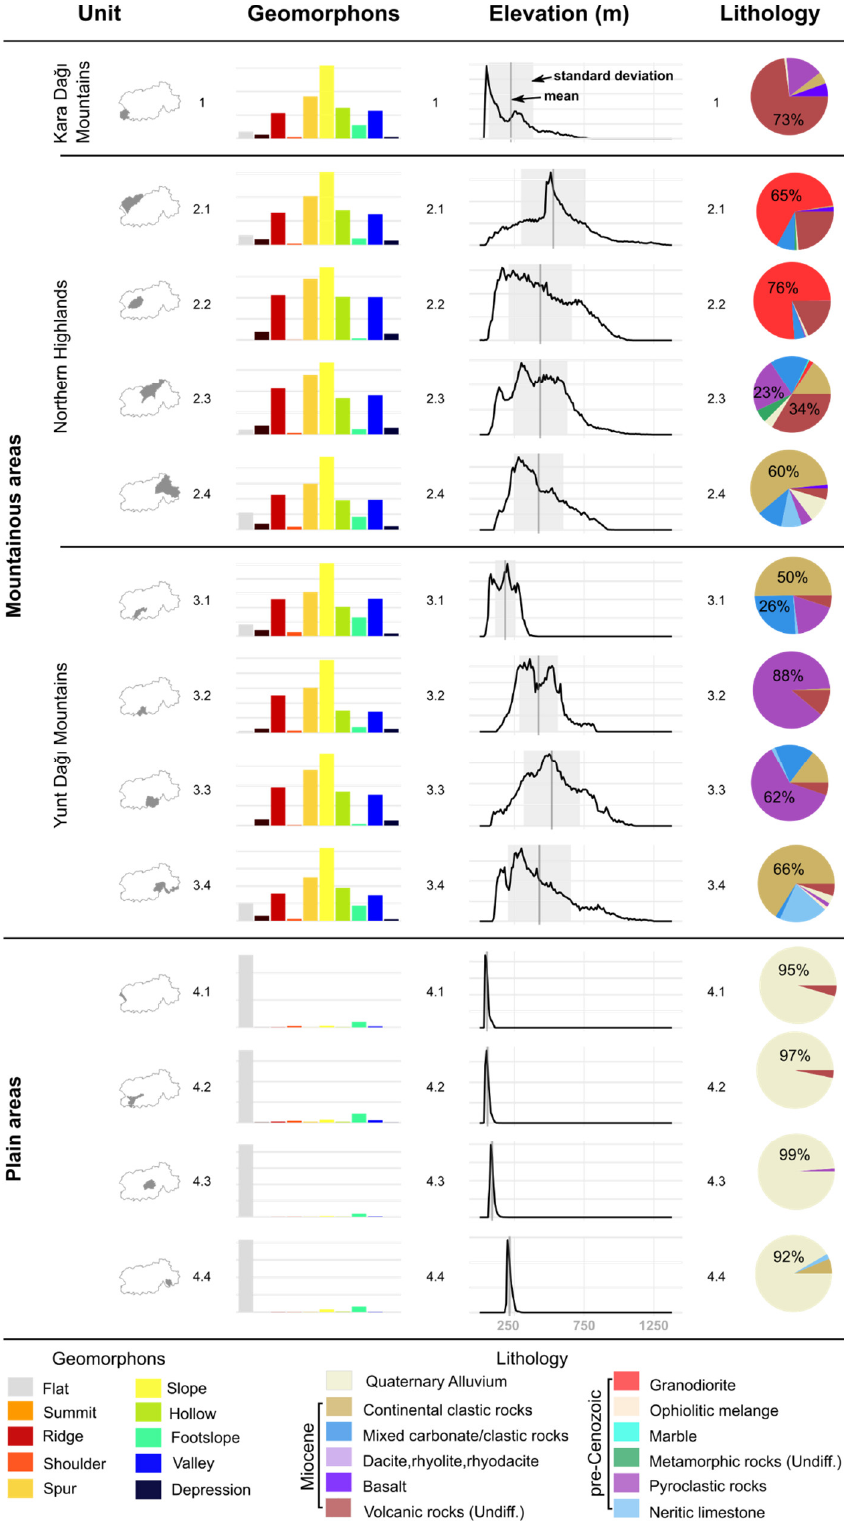
Figure 7. Distribution of the morphometric and lithologic characteristics of the Bakırçay and Madra River catchments, outlining geomorphological subunit distribution of geomorphons and elevation; y-axis shows the total number of pixels per geomorphon and per altitude range. Pie charts show the distribution of lithology.